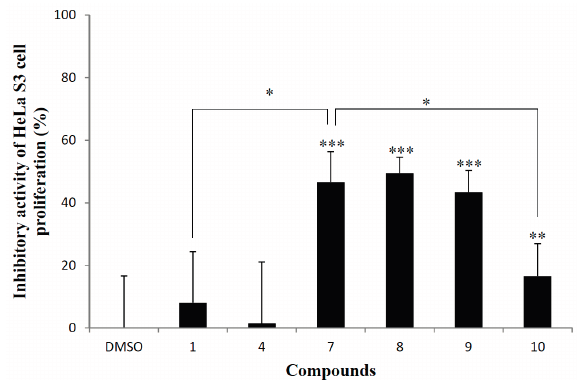
Figure 6. Inhibitory activity of synthetic dimeric flavan-3-ols against HeLa S3 cell proliferation. HeLa S3 was incubated with 1 μ L of DMSO solution of each compound (final 100 μ M) for 48 h. DMSO was used as a negative control. Error bars represent standard deviation of the mean ( n = 14). *** p < 0.001, ** p < 0.005 vs. DMSO-treated groups, asterisks indicate * p < 0.001 in Student’s t